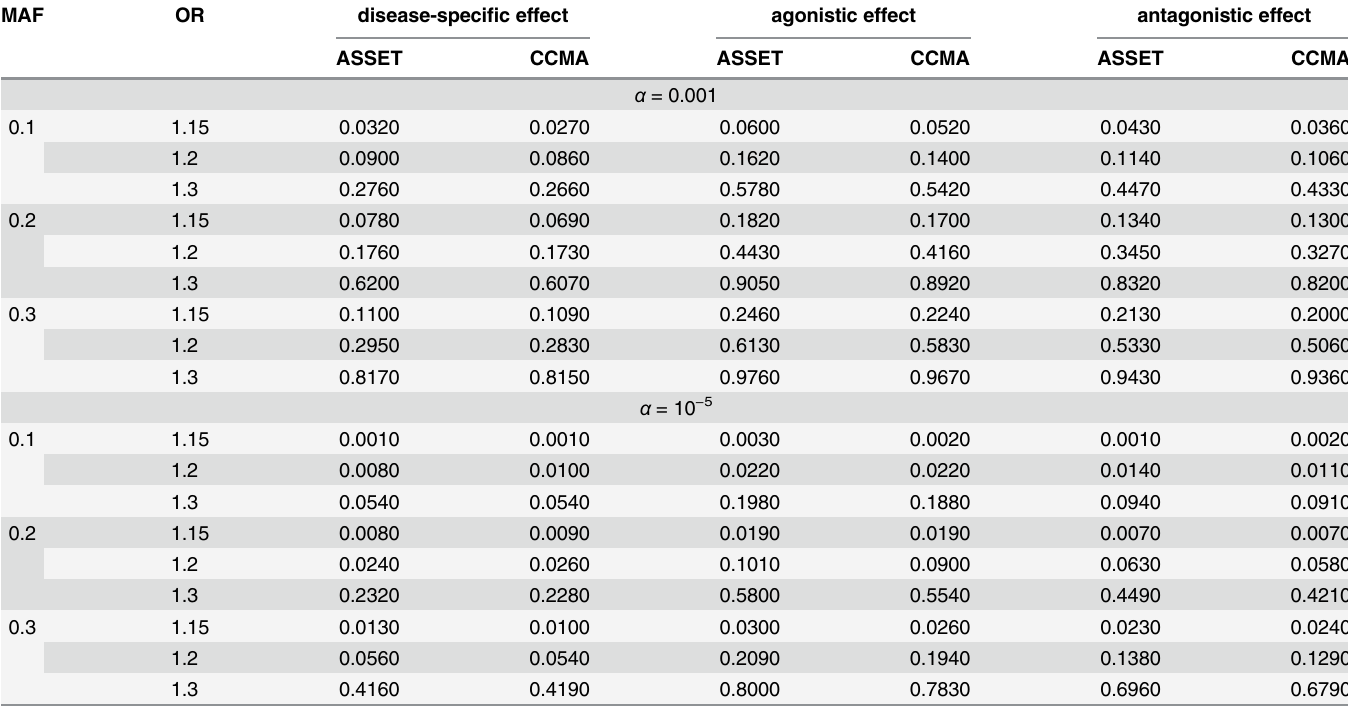
Table 2. Power comparison of the CCMA and Subset-Based Meta-Analysis (ASSET) for detection of true associations at a significance level of α = 0.001 and α = 10 − 5 . For each power estimate, we ran R = 1,000 simulations with n = 8,000 individuals for various MAF and OR values and assigned the dis- ease status by a multinomial model. MAF